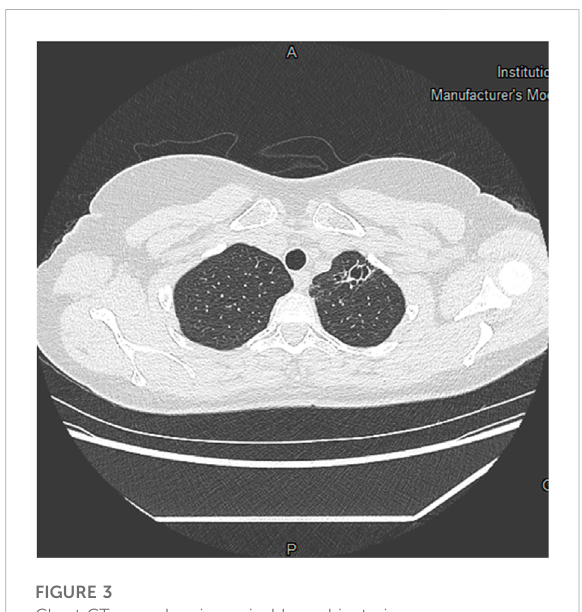
FIGURE 3 Chest CT scan showing apical